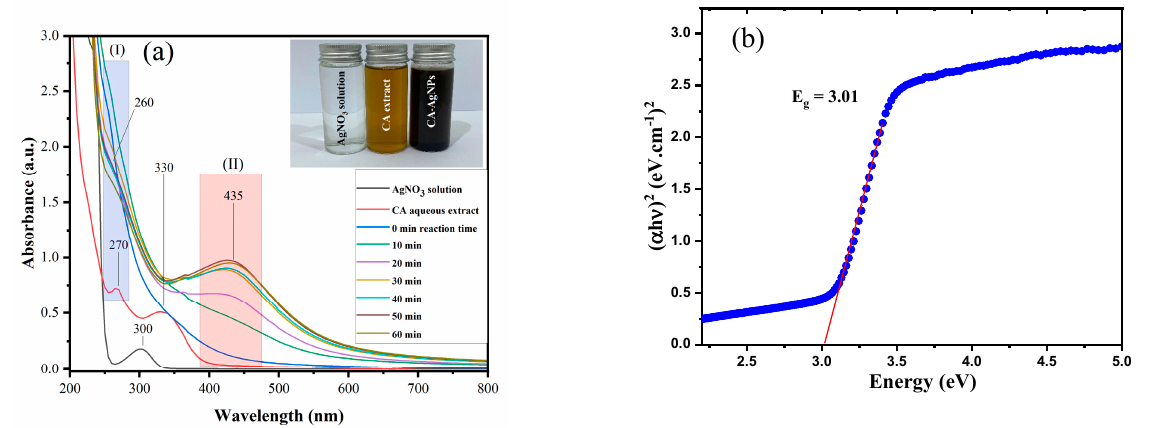
Figure 2. ( a ) UV-visible spectra of CA Extractand Biosynthesized CA-AgNPs; ( b ) Bandgap plot of CA-AgNPs.